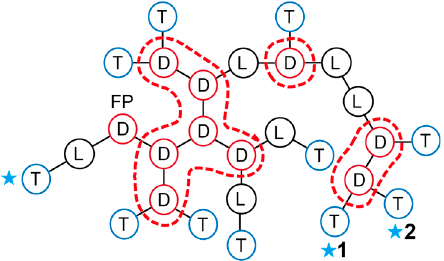
Figure 2. Schematic representation of a hyperbranched (HB) polymer molecule generated in the present Monte Carlo (MC) simulation for a continuous stirred-tank reactor (CSTR). The tri-branched clusters are shown by the red closed curves, and the T units with a star show the end units for the maximum span length.